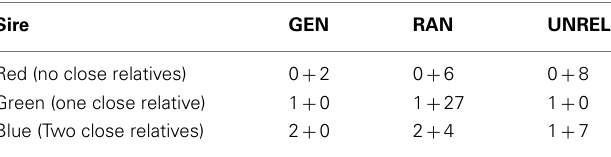
Table 4 | Summary of relatives in the training set for three testing sires common to all layouts (GEN, generational; RAN, random; UNREL,A-matrix decomposition).